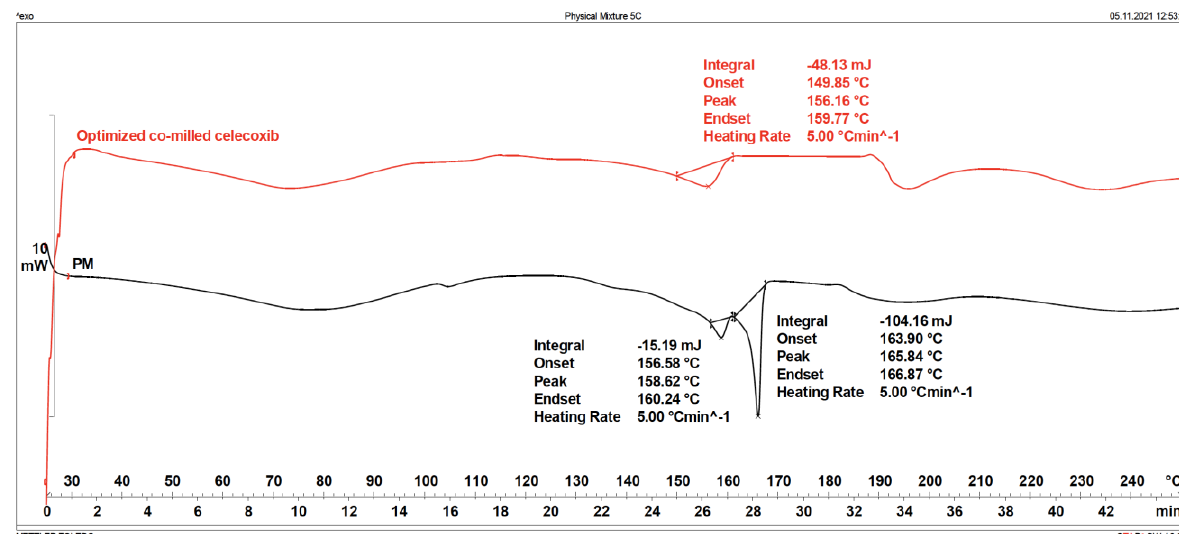
Figure 6. DSC thermograms of optimized co-milled CXB and PM.